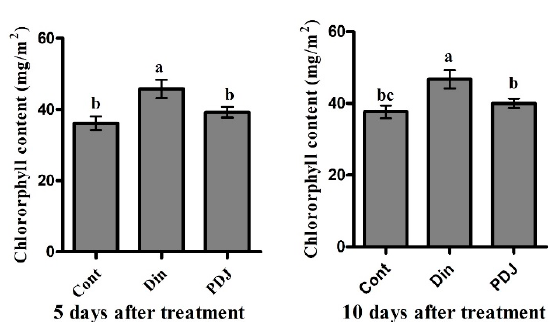
Fig. 2: Chlorophyll content of leaves per each treatment (Cont; Control, Din; Diniconazole, PDJ; Prohydrojasmon). The differences between the mean values were determined using a DMRT at P < 0.05. The re- sults were graphically presented using GraphPad Prism (version 5.0, San Diego, CA, USA). The SAS 9.1 was used for DMRT analysis.